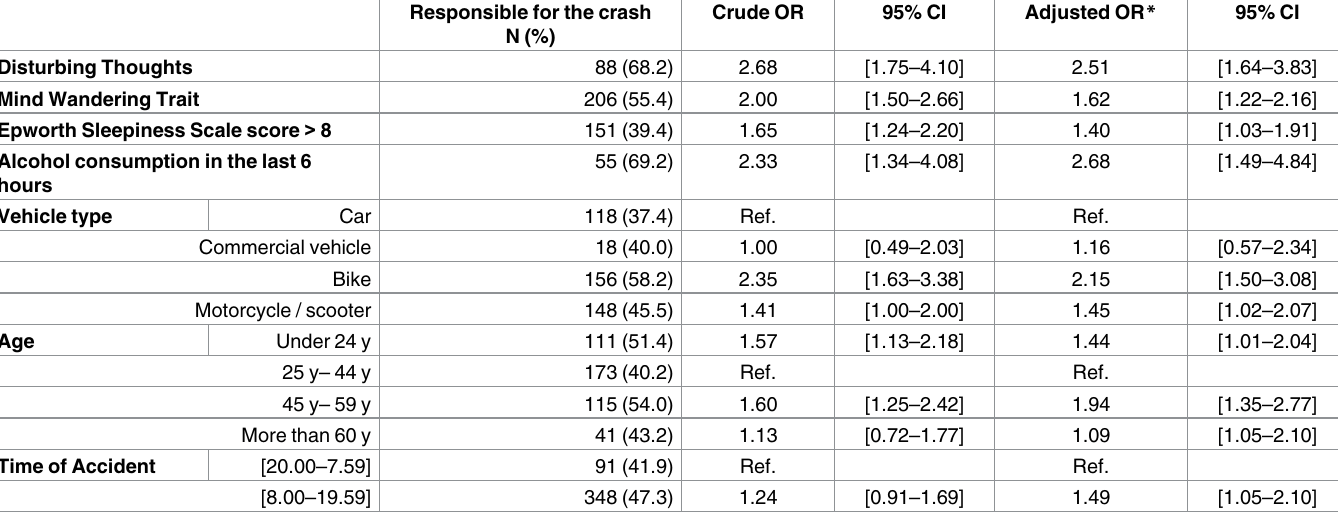
Table 2. Multivariate analysis of factors associated with crash responsibility (n = 926).